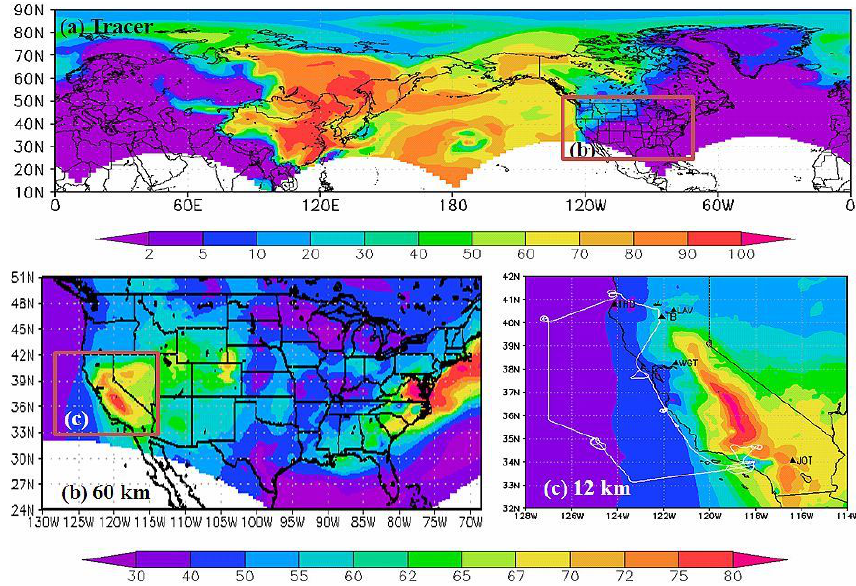
Fig. 1. (a) Averaged (24-h) surface contributions of anthropogenic China CO as % during 21–24 June in the entire tracer domain; averaged (24-h) O 3 concentrations at surface from the (b) 60km (partial domain) and (c) 12km (entire domain surface sites and 22 June DC-8 flight path included) model simulations during 18–28 June